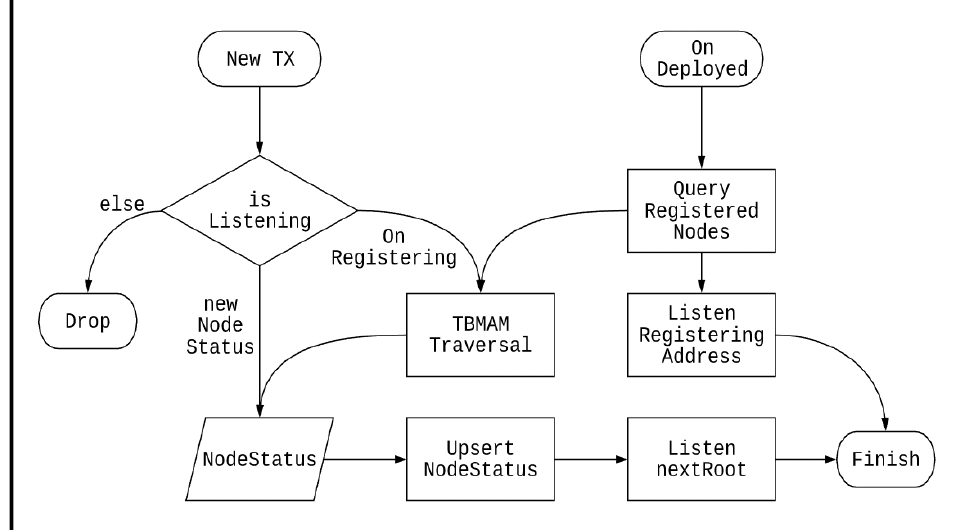
Figure 9. The mechanism of monitoring the nodes with the same service.